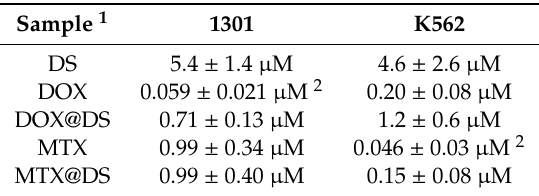
Figure 5. Viability profiles of 1301 ( A , C ) and K562 ( B , D ) cells after incubation with free chemodrugs and drug-loaded dendrimersomes. NT—non-treated cells. Incubation for 72 h, then WST-1 assay, data are presented as Mean ± S.D. (n = 5). * p < 0.05 vs. NT; # p < 0.05 free drug vs. drug@DS. Table 2. IC 50 values of blank dendrimersomes, chemodrugs and drug-loaded dendrimersomes towards 1301 and K562 cells.